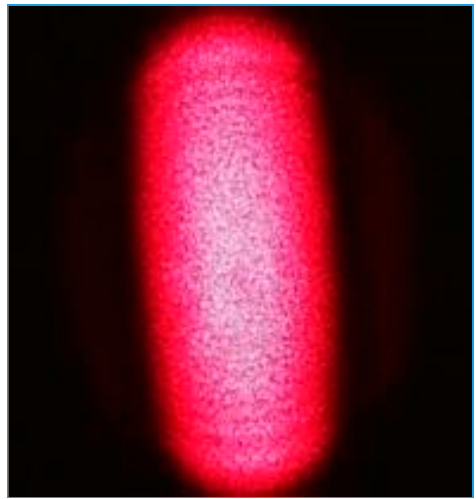
Figure A1. Laser speckle pattern.